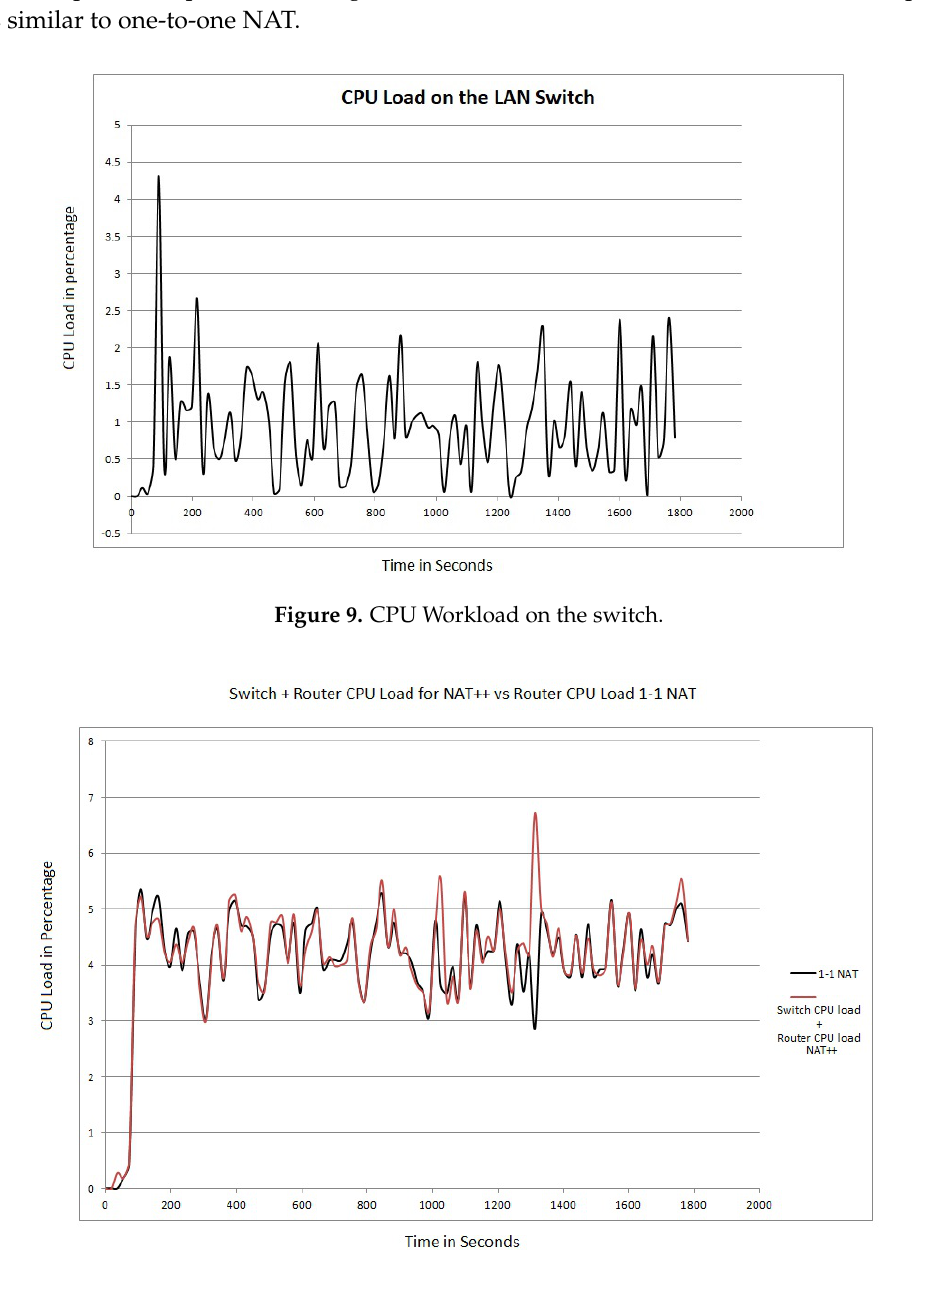
Figure 10. Total CPU Workload on the router and the